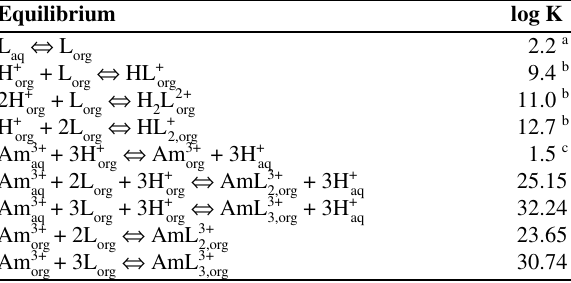
Table 6. Equilibrium constants in the water–HCl–Am 3+ (microa- mounts)–nitrobenzene– N,N,N’,N’ -tetrabutyl-1,10-phenanthroline- 2,9-dicarboxamide (L) –H + B – system.